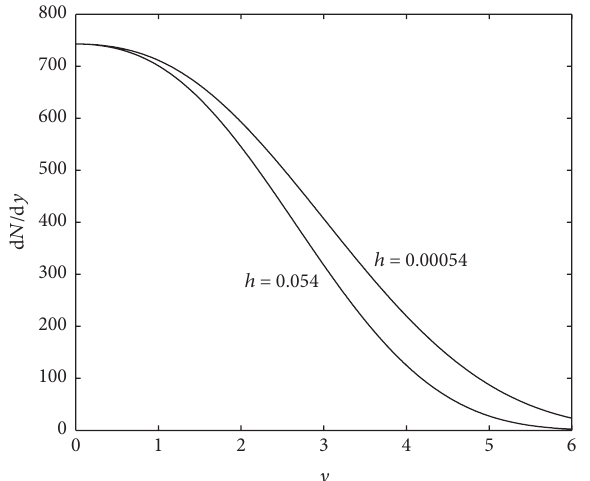
Figure 3: The rapidity distributions of produced charged particles for two different ℎ values in Au-Au collisions normalized to 0–3% centrality